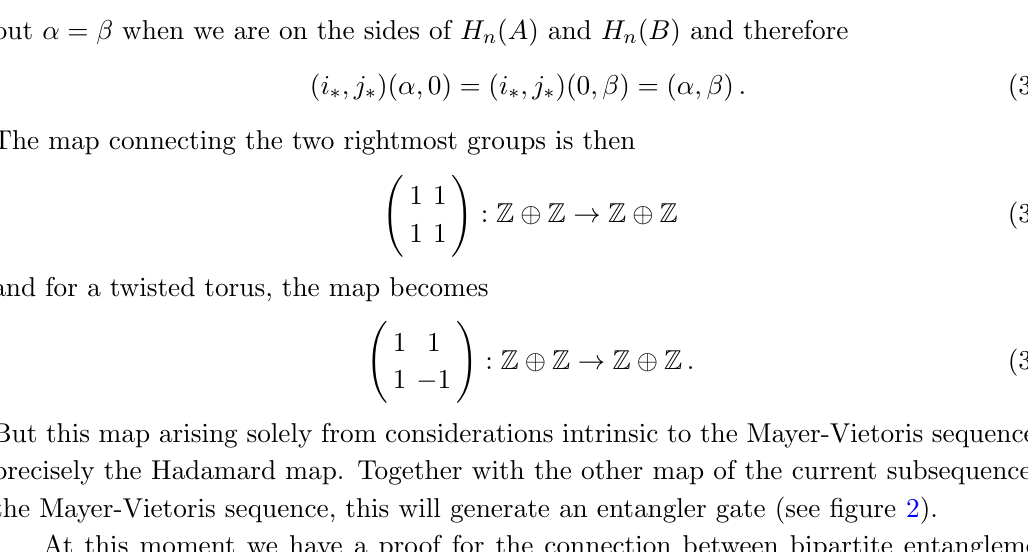
Figure 2 . Cutting the surface and assigning sheets to each of the resulting surfaces, then measuring the inclusion of the intersection of the surfaces in the respective sheets provides global information about the surface. One can therefore distinguish a torus from a deformed sphere by the fact that for a torus, the inclusion cannot be reduced back to a sphere by any smooth deformation. This is a basic example for the 2-dimensional torus. Cutting the torus by a planar surface gives two regions. Covering both of them with corresponding sheets and allowing those sheets to intersect on the handles of the torus will provide us with information about the topology of the torus [12]. Moreover, this construction also inevitably leads to inclusion maps of the form of Hadamard and c-NOT operations leading to an entangler